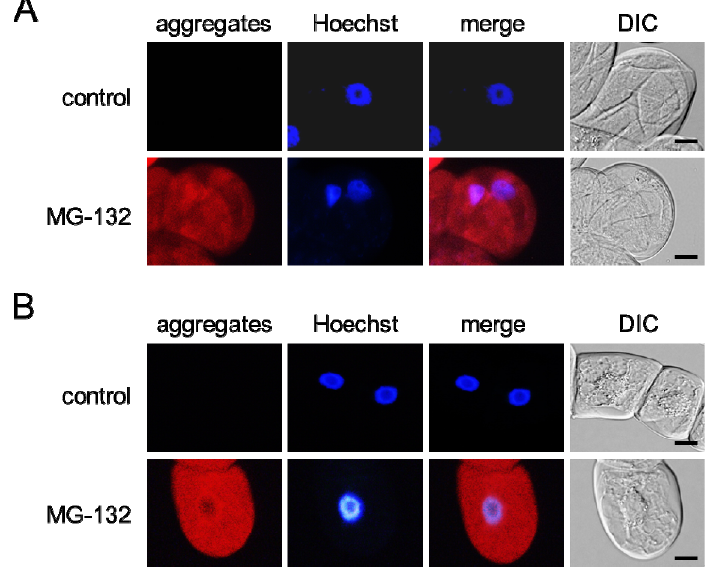
Figure 1. Misfolded protein aggregation in plant cells. Grape ( A ) and tobacco ( B ) cultured cells were treated with MG-132. The cells were stained with Hoechst 33342 (Hoechst) and then with a ProteoStat Aggresome Detection Kit (aggregates). The red color and the blue color indicate the fluorescence of detected aggregates and stained nuclei, respectively. Merge, a merged image. DIC, an image observed under a differential-interference-contrast (DIC) microscope. Scale bars, 20 μ